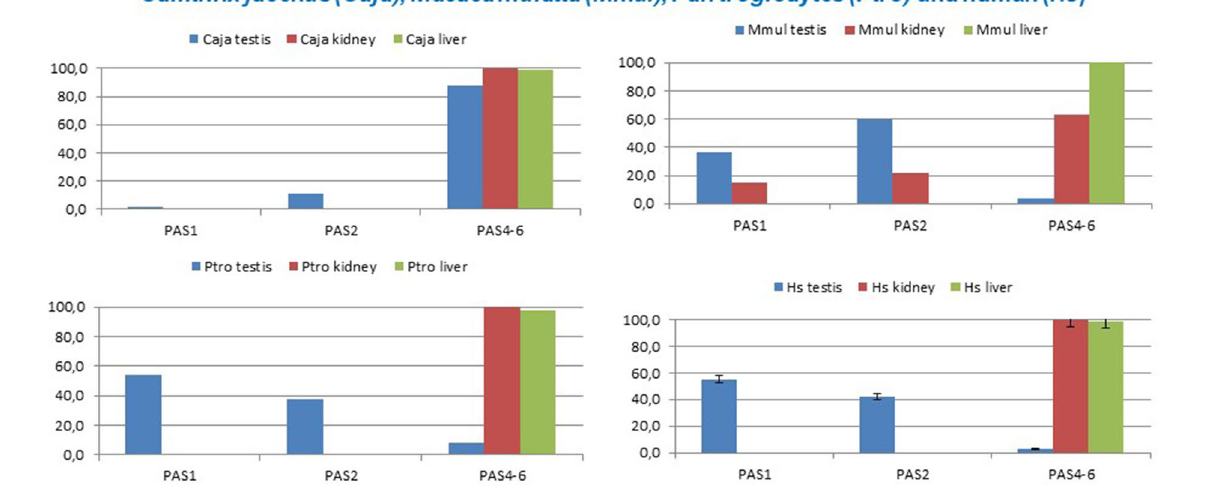
Figure 2. Quantitative evaluation of polyadenylation processing of DDX3Y transcripts in testis, kidney, and liver tissue when using one of the proximal 3´UTR polyadenylation sites, (PAS1, PAS2), respectively, one of the distal PAS4-6 in Callithrix jacchus, Macaca mulatta , Pan troglodytes and human. Comparison of DDX3Y transcripts was performed in parallel with three distinct TaqMan probes (“PAS1”; “PAS2”, “PAS4-6”) by appropriate TaqMan assays in as described in Material & Methods section (for specification and location of primer sequences see supplementary information: Table S3). Most DDX3Y transcripts in Callthrix jacchus (Caja) are processed for polyadenylation in the distal 3´UTR part as assessed by TaqMan probe “PAS4-6”. Only in testis tissue about 10% of the DDX3Y transcripts become polyadenylated after PAS2 and less than 1% at PAS1. This corresponds to the data of our RT-PCR assays shown in Fig. 1. In Macaca mulatta (Mmul), more than 90% of the DDX3Y testis transcripts and more than 30% of DDX3Y transcripts in kidney are polyadenylated at PAS1 and PAS2, respectively. In liver tissue, DDX3Y transcripts are processed for polyadenylation only in the distal 3´UTR containing PAS4-6. In Pan troglodytes (Ptro) and human (Hs), all DDX3Y transcripts expressed in kidney and liver are processed in distal 3´UTR after PAS4-6, whereas in testis tissue PAS1 in the proximal 3´UTR is the major polyadenylation site. Less than 5% of DDX3Y transcripts in the testis tissue are processed for polyadenylation after PAS4-6. Numbers on the scale at the left of each diagram represent percentage